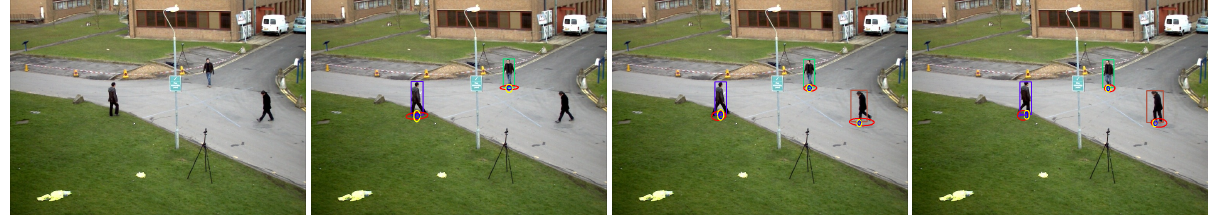
Figure 4. Frame 1 (left column) to 4 (right column) of the PETS09-S1L2